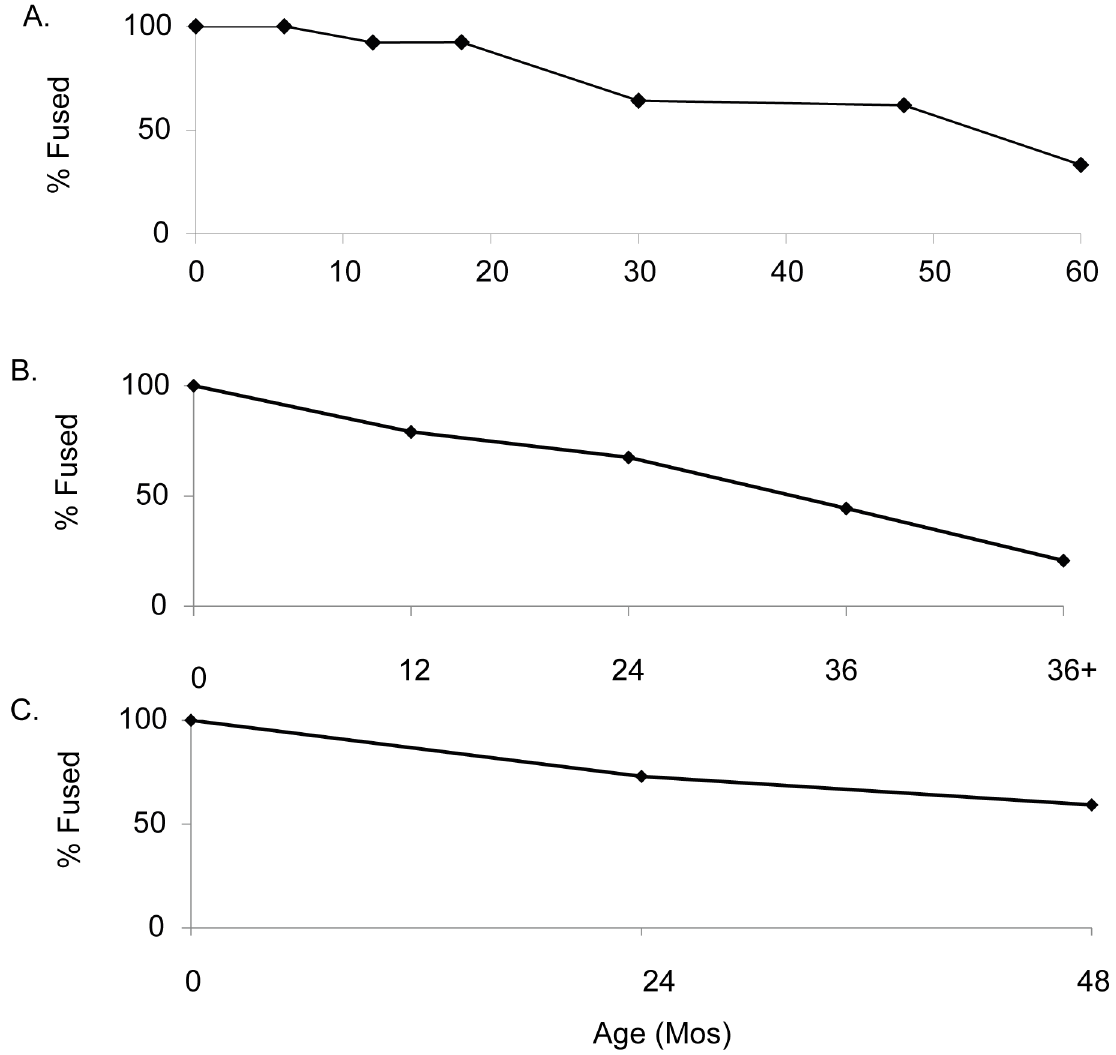
Fig 4. Survivorship of (A) Capra (n = 317) [56]. (B) Sus (n = 127) [58]. (C) Bos (n = 90) [58]. Based on fusion data. Y-axis indicates proportion of fused specimens for elements that fuse by that